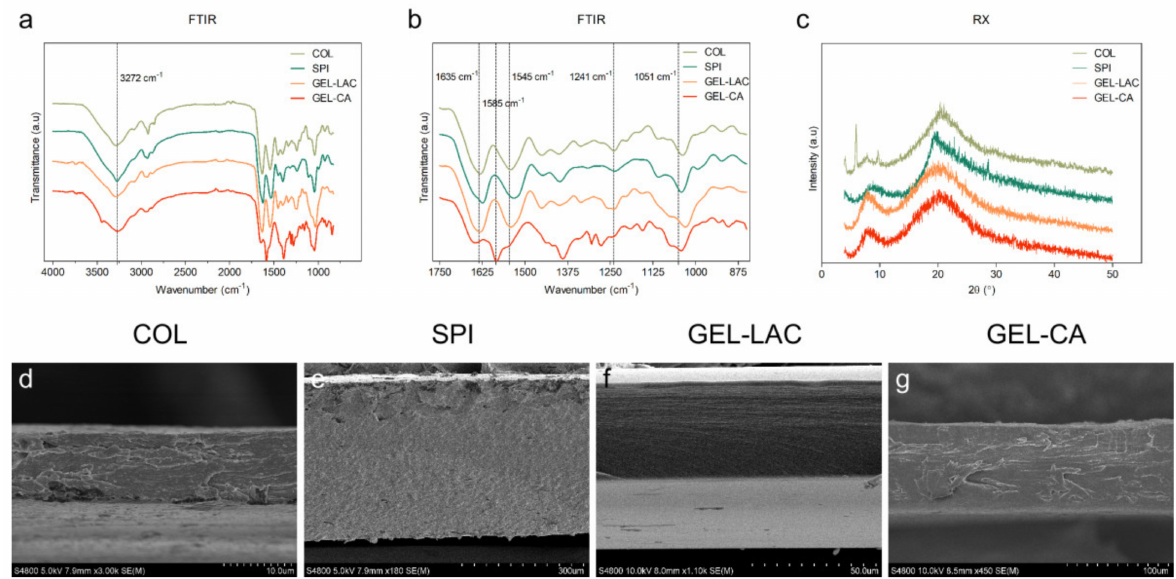
Figure 1. FTIR spectra of films ( a ) from 4000 to 850 cm − 1 and ( b ) from 1750 to 850 cm − 1 . ( c ) XRD patterns of films. ( d – g ) SEM image sections of films obtained with ( d ) 3000 × , ( e ) 180 × , ( f ) 1100 × , and ( g ) 450 × magnification. COL, collagen; SPI, soy protein isolate; GEL-LAC, lactose-cross-linked gelatin; GEL-CA, citric acid-cross-linked